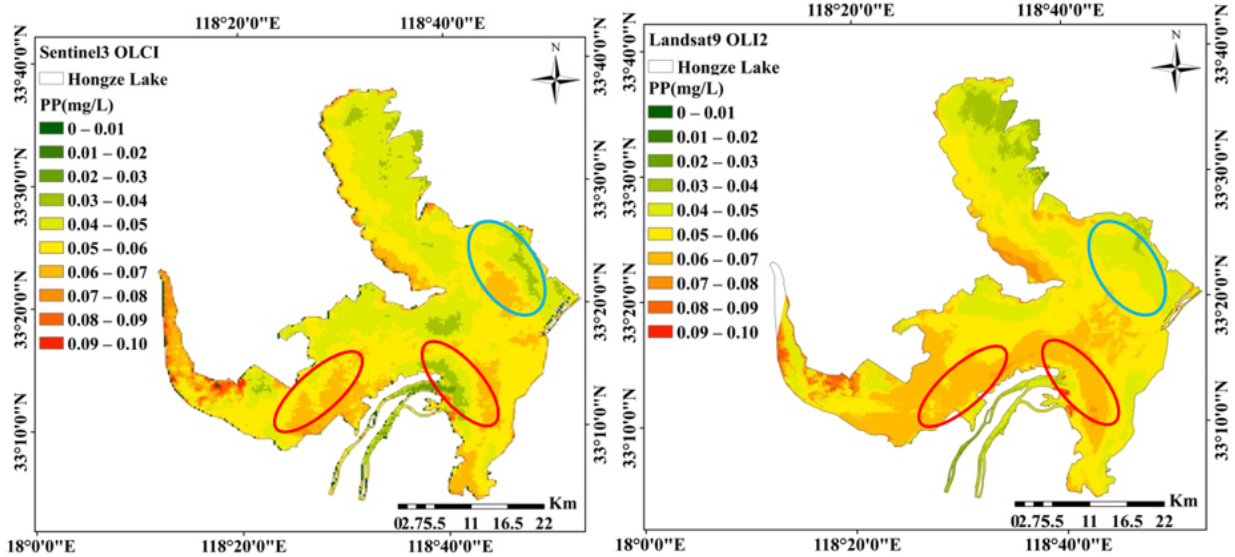
Figure 11. PP concentration estimations obtained from remotely sensed data obtained on 16 January 2022. uary